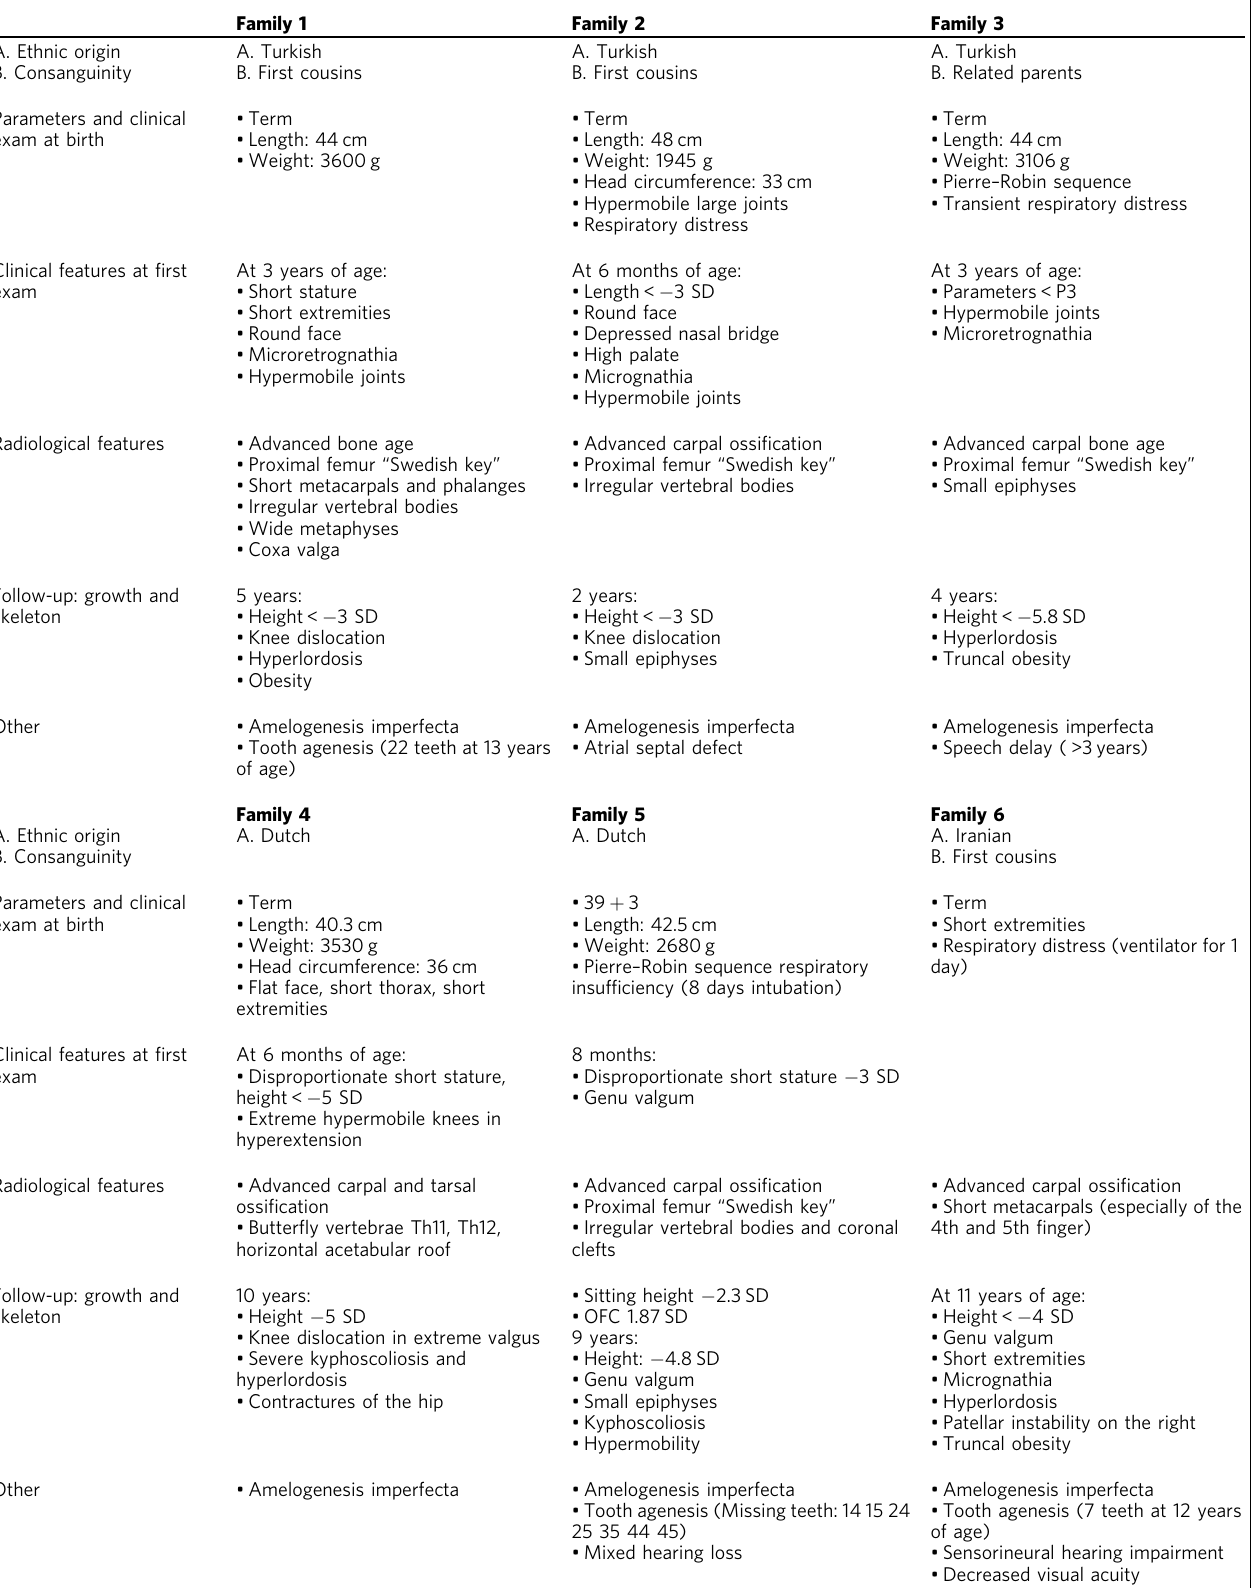
Table 1 Clinical features of the six